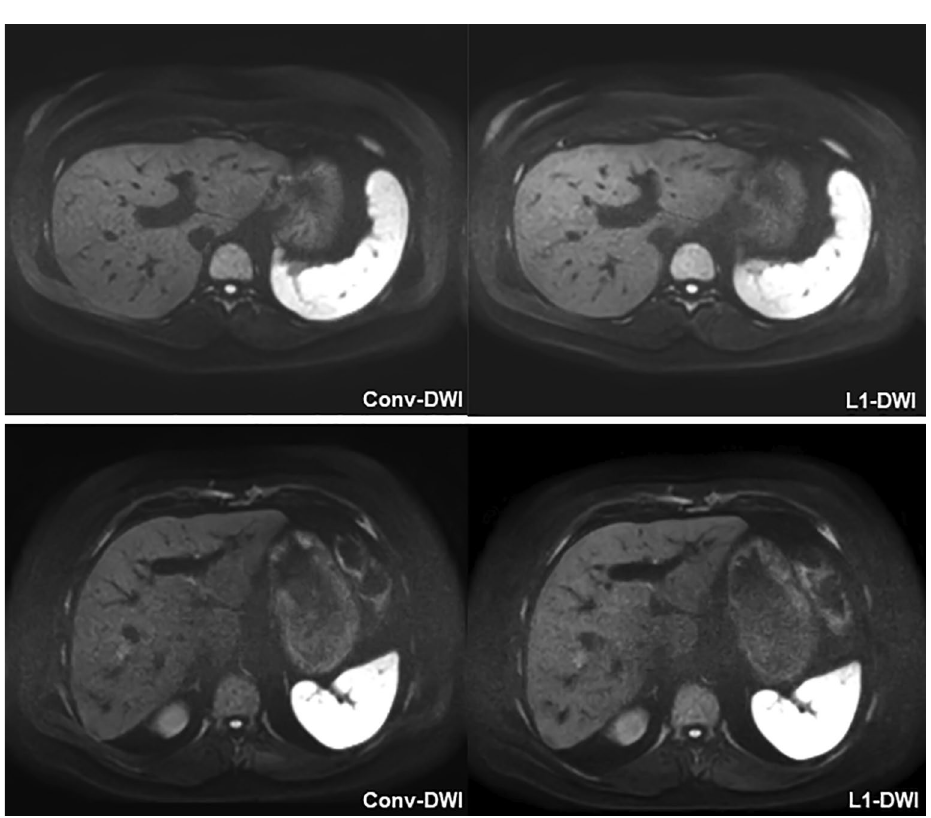
Figure 3. Images of conv-DWI and L1-DWI obtained with the L1-protocol in group A and group B. Representative images of conv-DWI and L1-DWI obtained with the CS-protocol in group A (upper row) and group B (lower row) yielding equivalent ratings for conv-DWI and